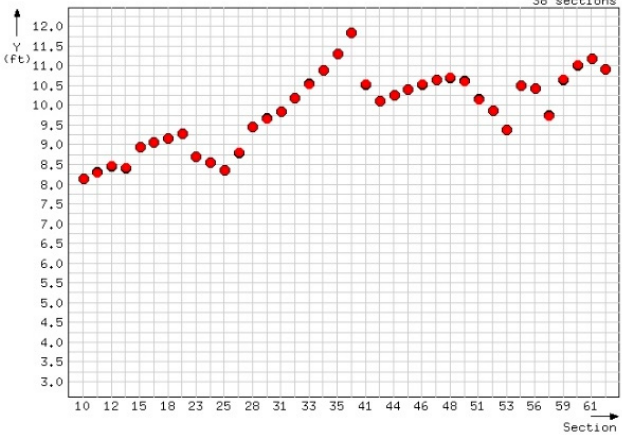
Figure 13 . Dataset 3: Critical depths of case 1 sections Figure 13. Dataset 3: Critical depths of case 1